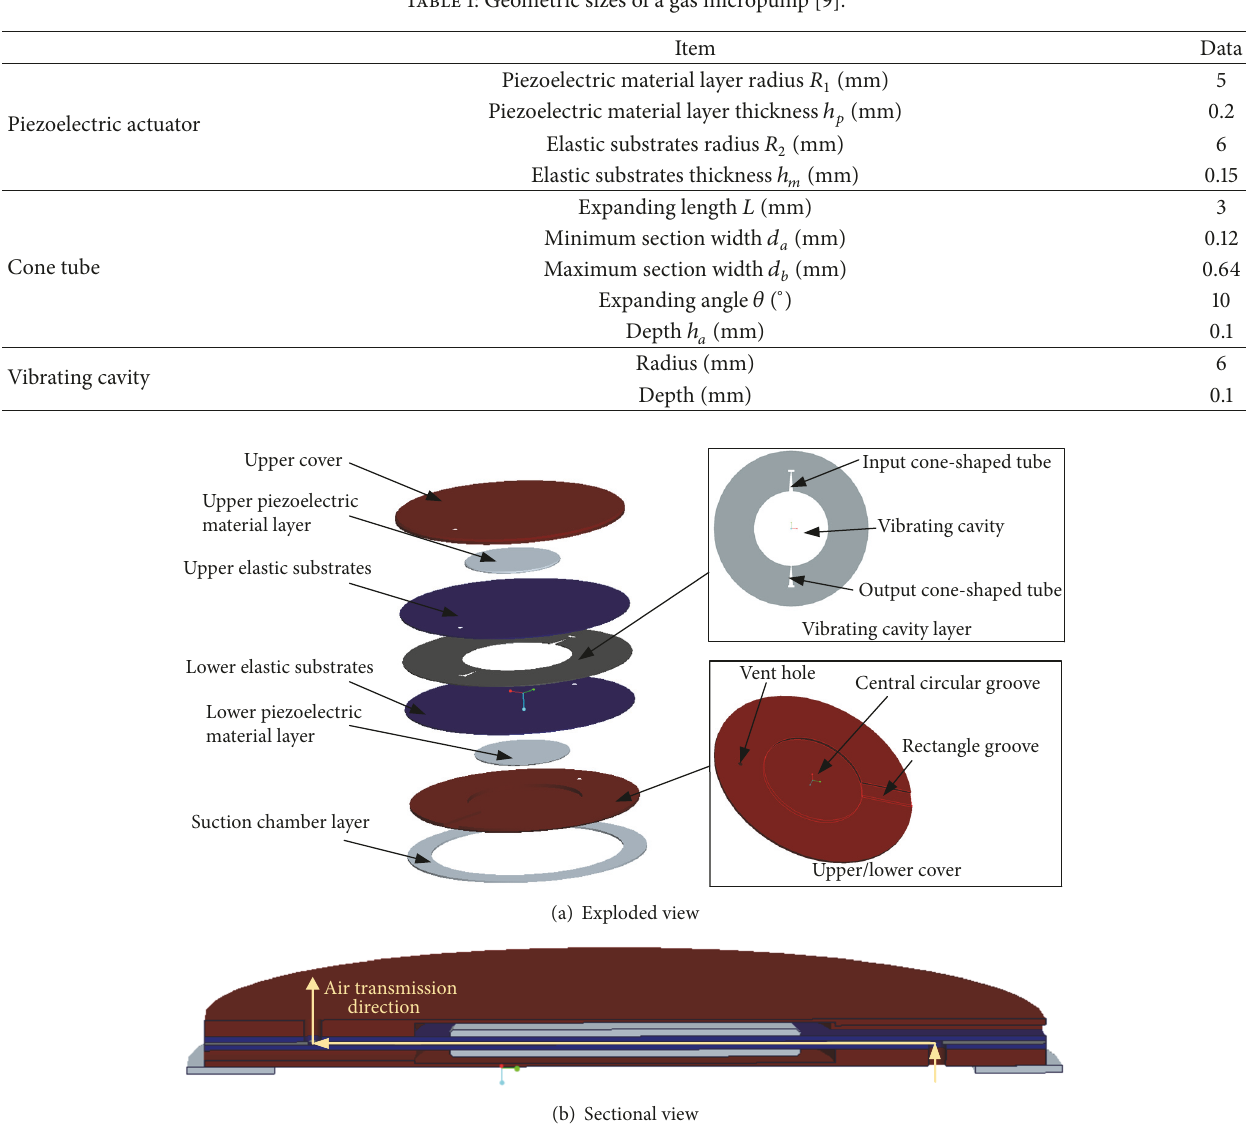
Table 1: Geometric sizes of a gas micropump [9].